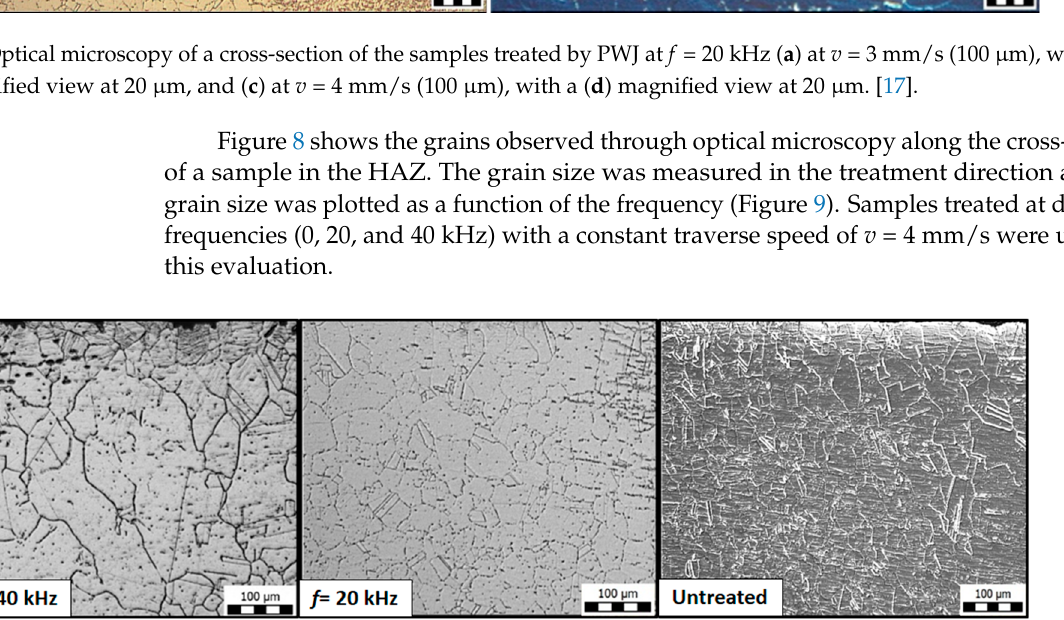
Figure 8. Optical microscopy of a cross-section of the samples in the HAZ at 100 µm.